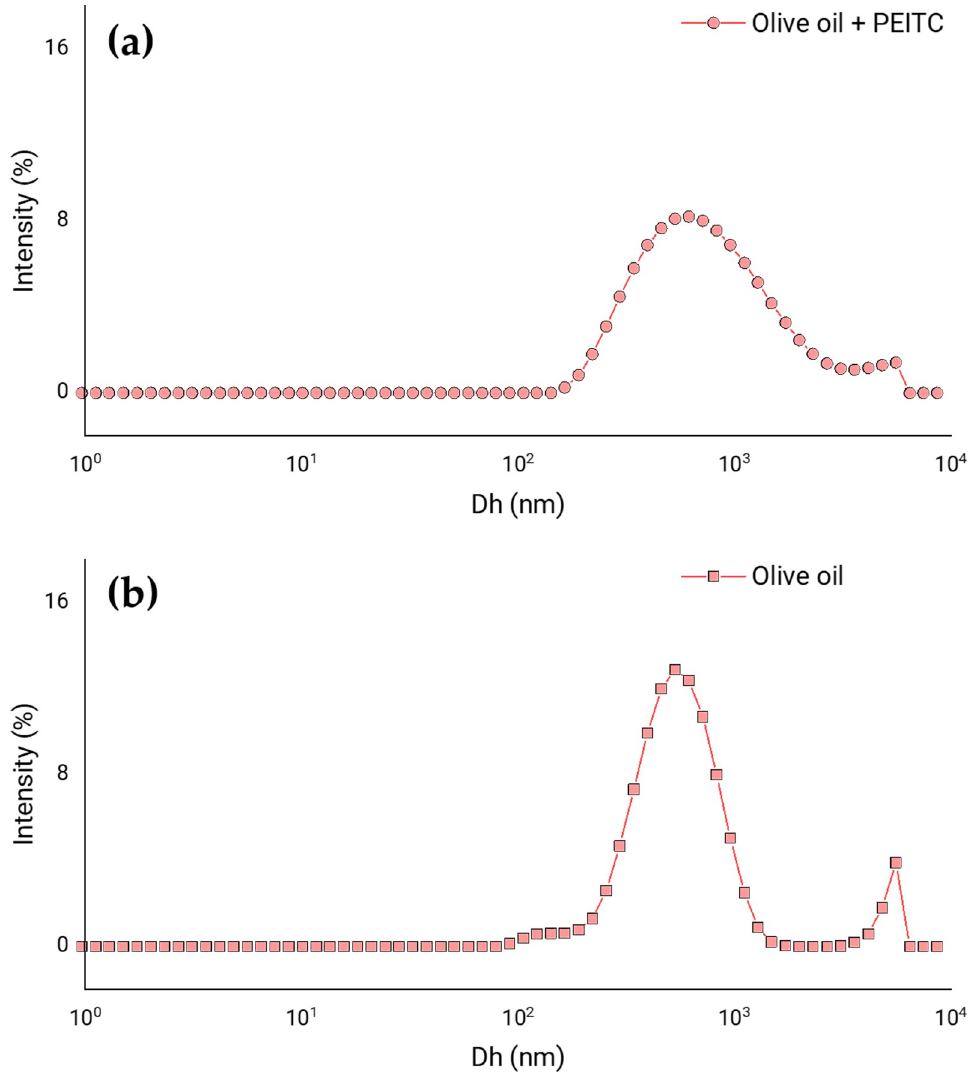
Fig 4. Effect of olive oil. Distribution of apparent hydrodynamic diameters (Dh) according to the percentage of dispersion intensity, showing the effect of the incorporation of olive oil in the formulation of CS MPs loaded with PEITC. Results corresponding to the MPs with a mass ratio of olive oil: CS of 1.25 to 1.00, with PEITC ( a ) and without PEITC ( b ).